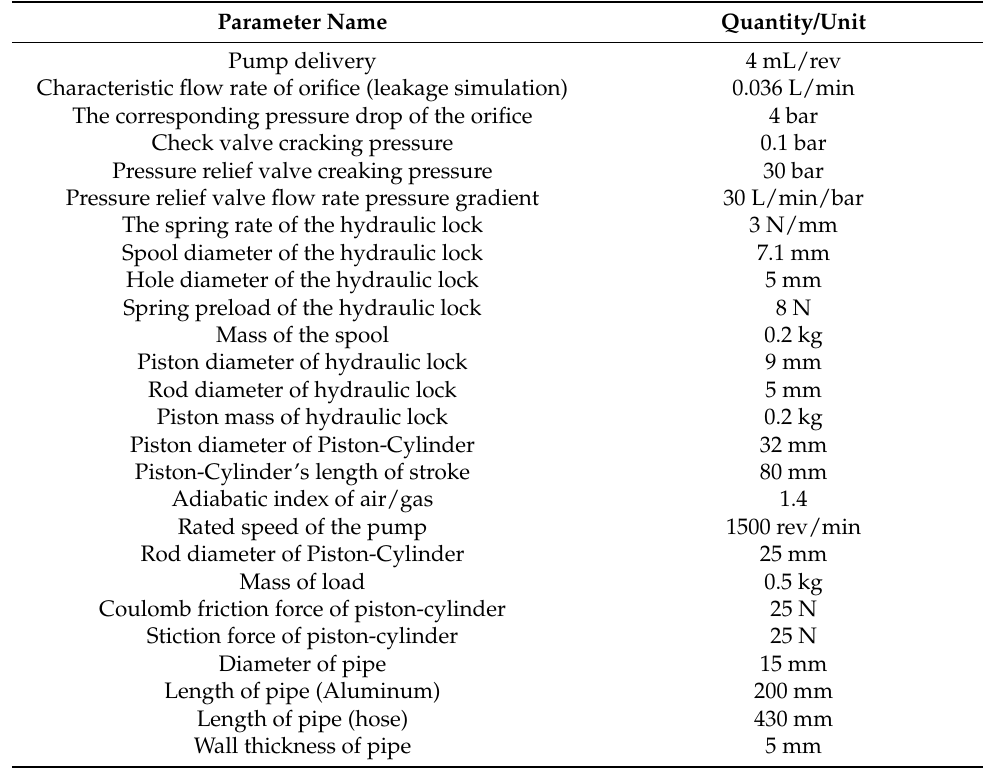
Table 2. The parameter of the hydraulic system.